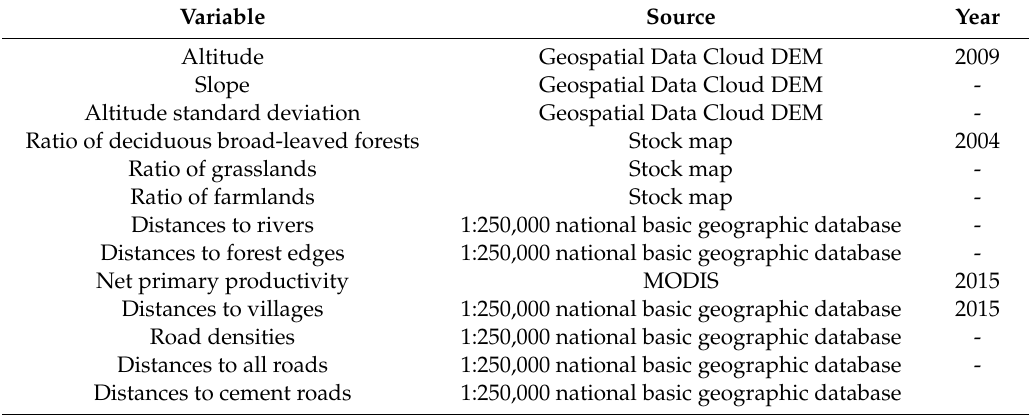
Table 1. Environmental variables used in the analysis of red deer resource selection Forest Service. Variable Source Year Altitude Geospatial Data Cloud DEM 2009 Slope Geospatial Data Cloud DEM - Altitude standard deviation Geospatial Data Cloud DEM - Ratio of deciduous broad-leaved forests Stock map 2004 Ratio of grasslands Stock map - Ratio of farmlands Stock map